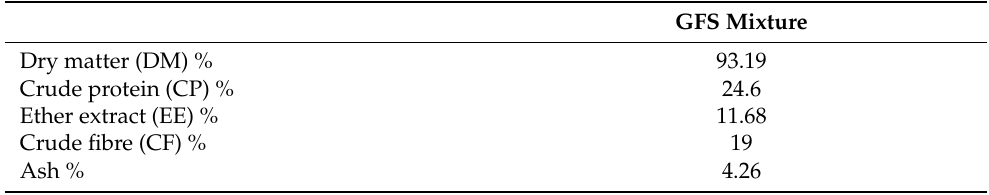
Table 1. Chemical composition of meal mix (g/100 g sample).